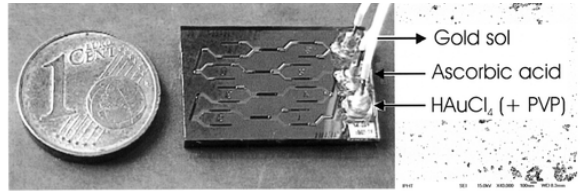
Figure 8. Set-up of a microfluidic reactor used for the synthesis of gold nanoparticles